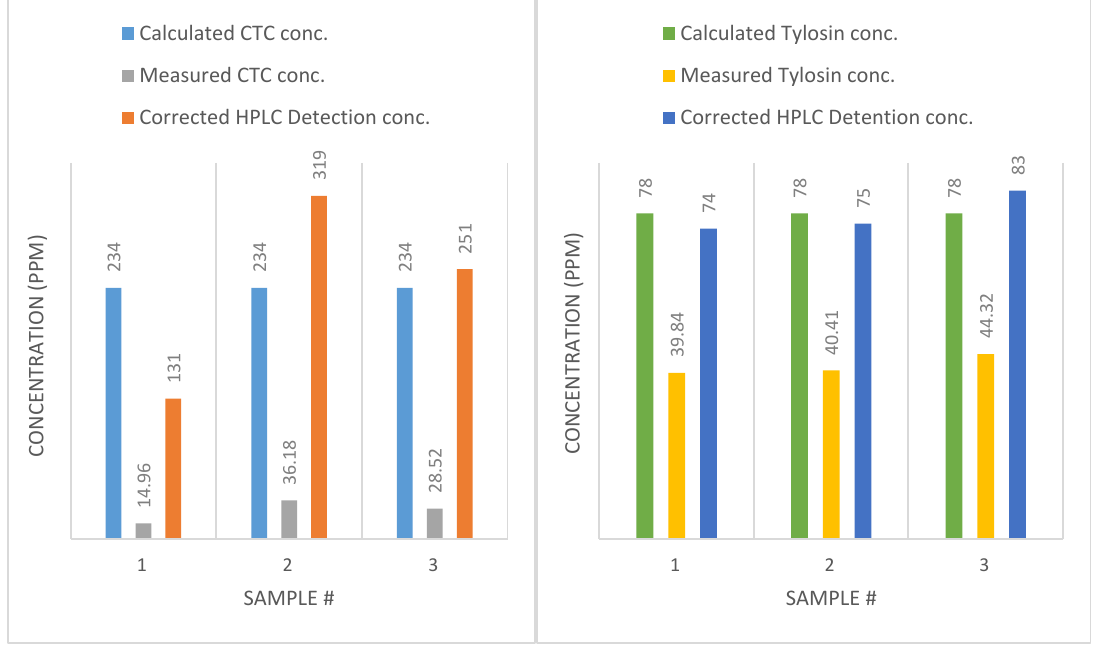
Figure 7. Left : concentrations of CTC, comparing calculated, measured, and corrected concentrations. Right : concentrations of tylosin, comparing calculated, measured, and corrected concentrations.